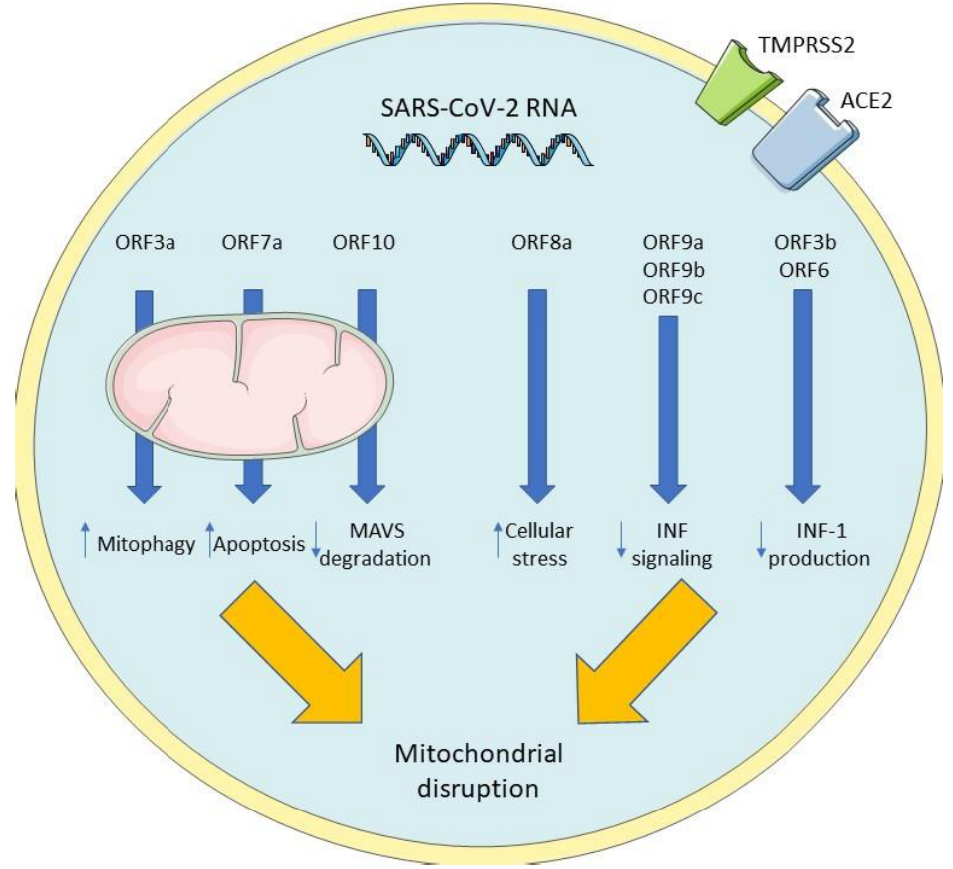
Figure 4. Metabolic changes caused by SARS-CoV-2 virus in the host cell. Open reading frames (ORFs) are responsible for various changes to the host cell metabolism, which are focused on damaging mitochondria.